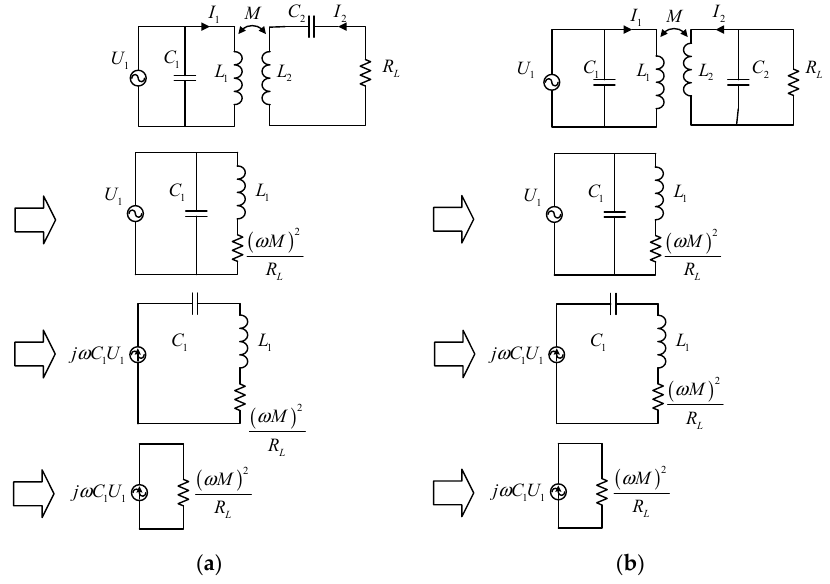
Figure 8. The SP and PP compensation Witricity circuit using the equivalent circuit B. ( a ) The SP compensation Witricity circuit; ( b ) The PP compensation Witricity circuit.